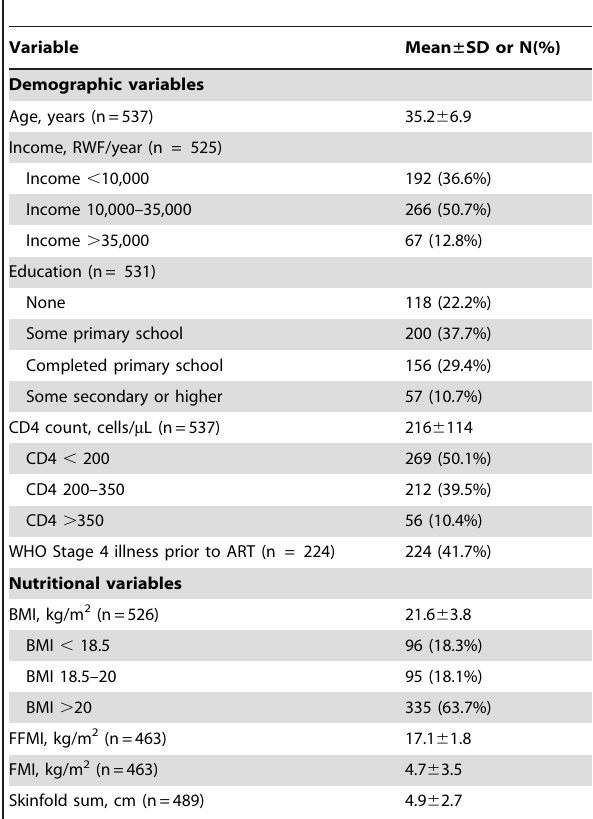
Table 1. Characteristics of 537 HIV-infected women participants prior to initiation of antiretroviral